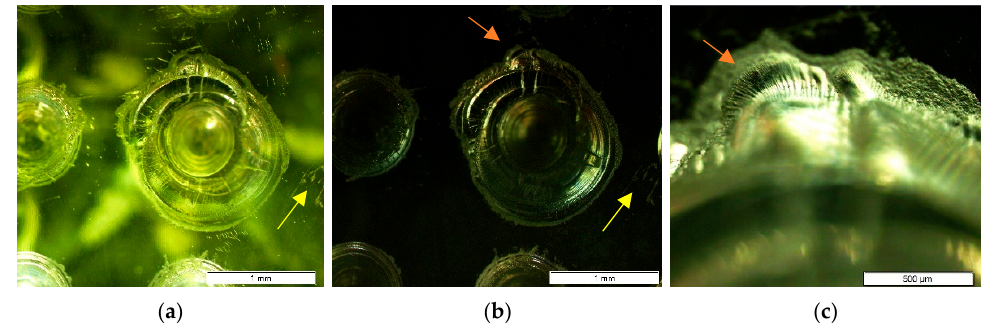
Figure 4. Surface inspection—microscope view ( a ) Before sputtering (20×) ( b ) After sputtering (20×) ( c ) Coating quality (40×).